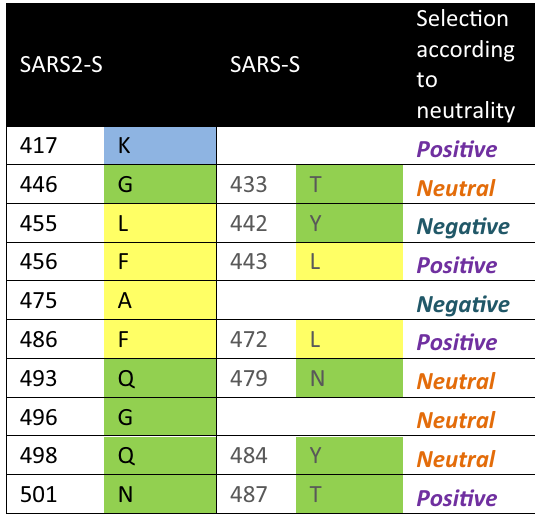
Table 2. Unique residues for SARS2-S involved in protein–protein interaction with ACE2. The selection type according to the neutrality test are mentioned specifically for SARS2-S. Other ACE2 binding spike proteins expressed different a.a. Here SARS-S is shown as an example. The empty spaces in SARS-S are a.a. that do not a.a. interact with ACE2.